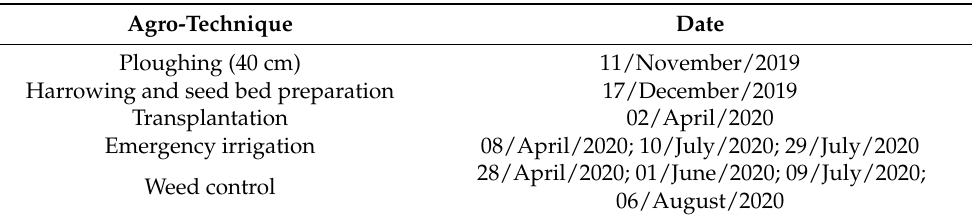
Table 3. Agronomic management practices using during the experimental period